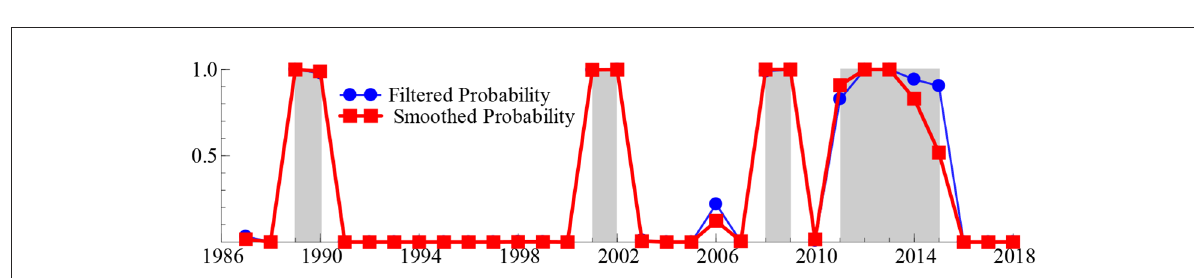
FIGURE4 The smooth probability time dynamic path of the medium-growth regime.